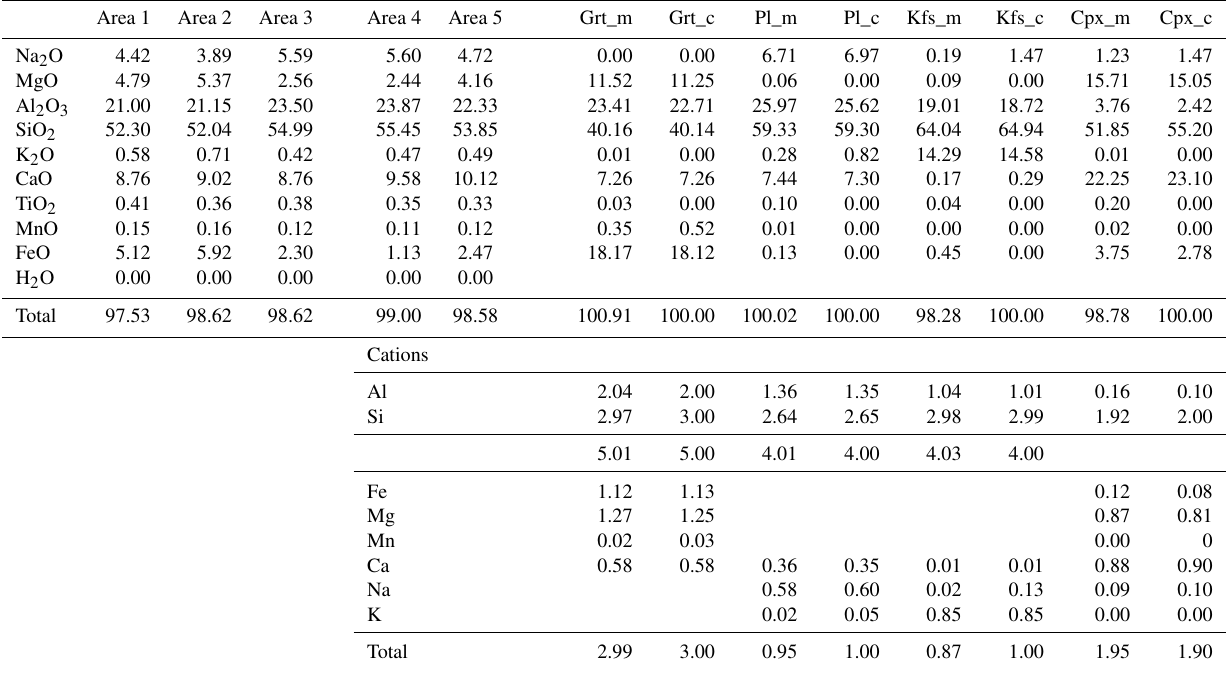
Table B2. Representative analysis for sample S5; m: measured; c: calculated from Perple_X at 1.2GPa and 690 ◦ C, all mineral chemistry from area 2. Solution models: Omph(GHP), GlTrTsPg, melt(HP), Chl(HP), Sp(HP), Gt(GCT), Opx(HP), Mica(CHA1), Ctd(HP), St(HP), Bio(TCC), hCrd, Osm(HP), Carp(HP), Sud, feldspar, IlGkPy, Neph(FB),